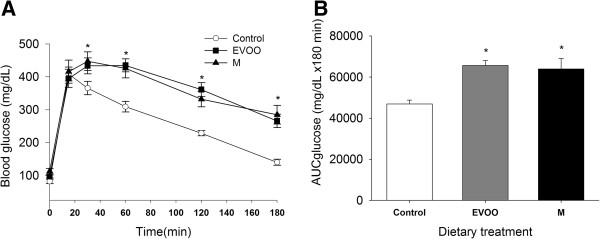
Effect of the HF-diets on blood glucose levels. Glycemia (A) and the area under the glucose curve (B) after 12 hours of fasting following an IP injection of 3 g/kg of glucose solution in rats fed a control or a high-fat diet (EVOO or M) for 20 weeks by 2-way RM ANOVA (for A) and one-way ANOVA (for B). *P < 0.05, significant difference compared with the control group. (n = 9 per group).